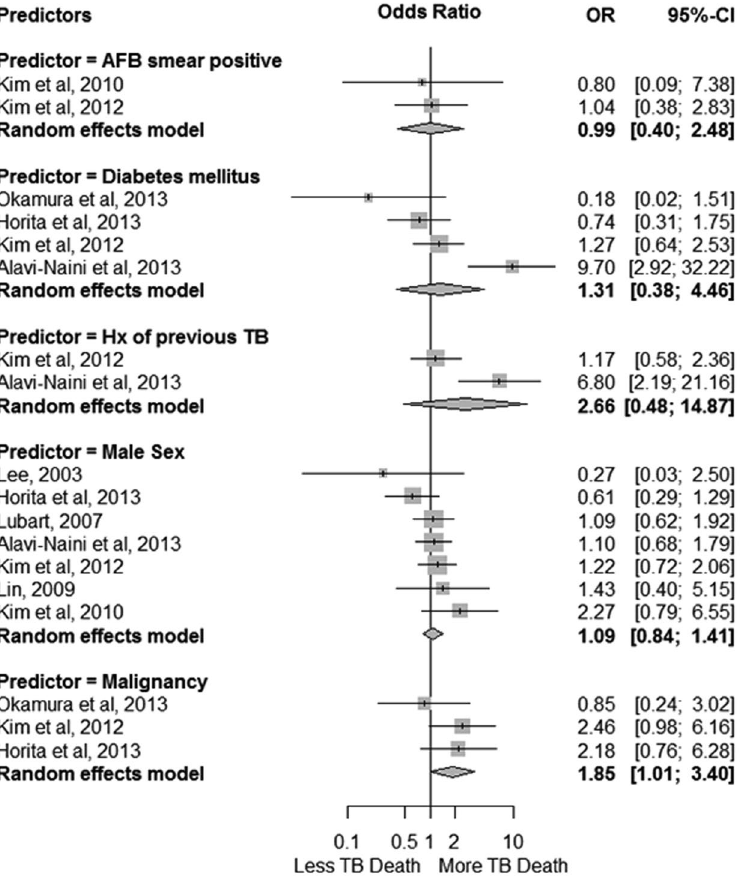
Figure 2. Association between AFB smear positive, Diabetes Mellitus, Hx of previous TB, Malignancy, male sex and in-hospital mortality among pulmonary TB patients.